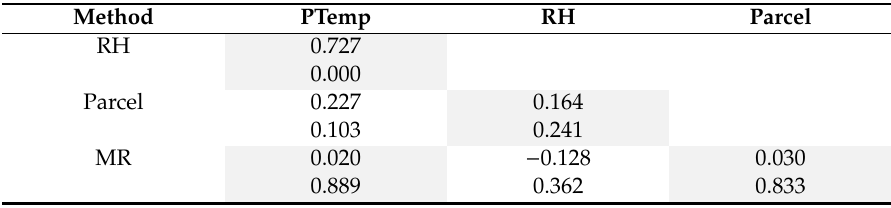
Table 2. Correlation of ABLH estimated using di ff erent methods. RH is the relative humidity gradient (radiosonde); PTemp is the potential temperature gradient (radiosonde); and MR is the mixing ratio gradient method (MODIS). Within each cell, the upper number is the correlation coe ffi cient (R), and the lower number is the p -value for the significance of the correlation. p -values less than 0.05 are considered significant.